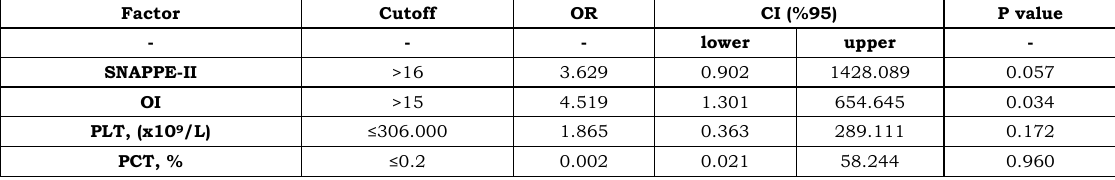
Table 3. Multivariate logistic regression analysis of parameters in CDH patients Factor Cutoff OR CI (%95) P value - - lower upper